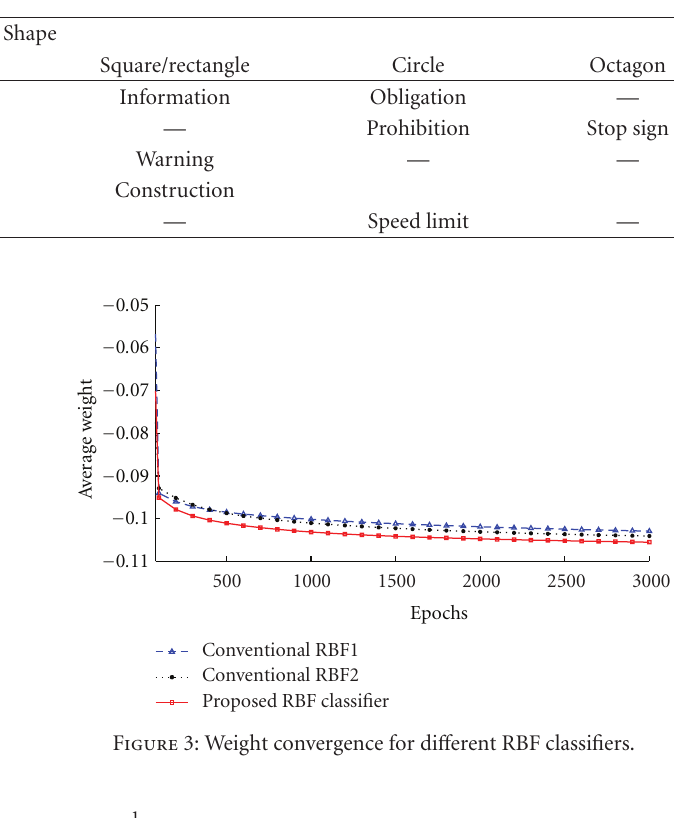
Table 1: Malaysia tra ffi c sign classification in shape and color.